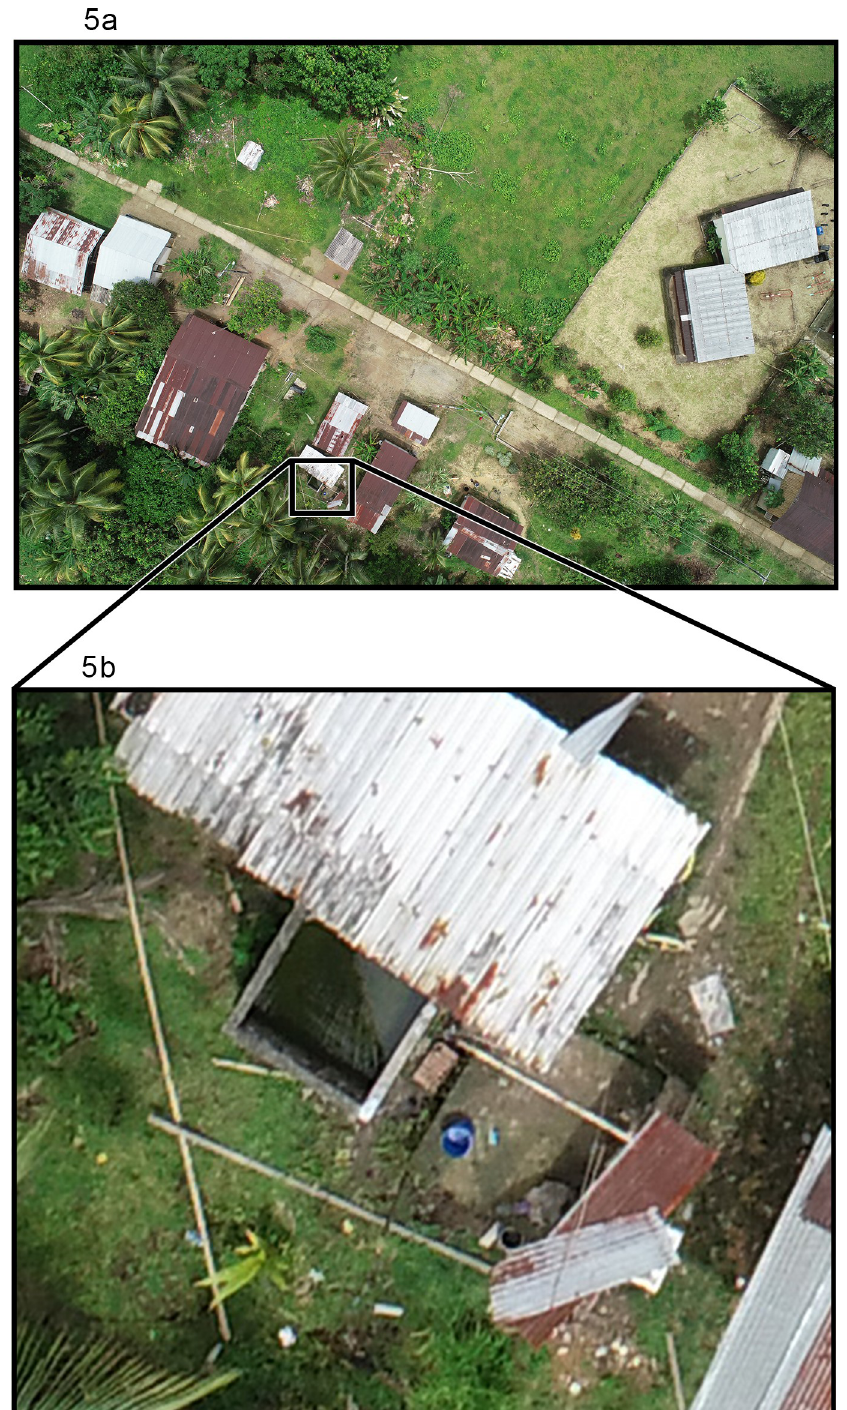
Fig 5. UAV images : Larger, outdoor potential larval habitats such as cisterns and rain barrels can be identified from UAV images (Fig 5A and 5B).